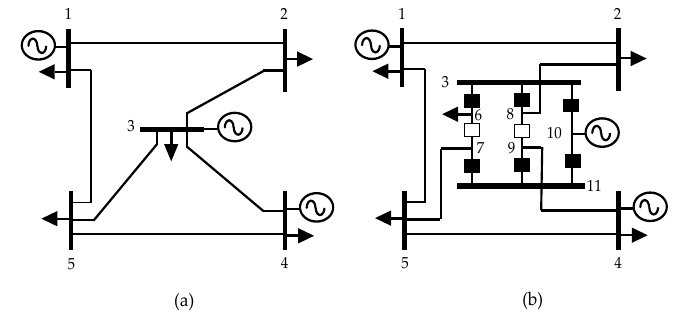
Figure 1. ( a ) Bus-branch modeling and ( b ) substation level modeling.